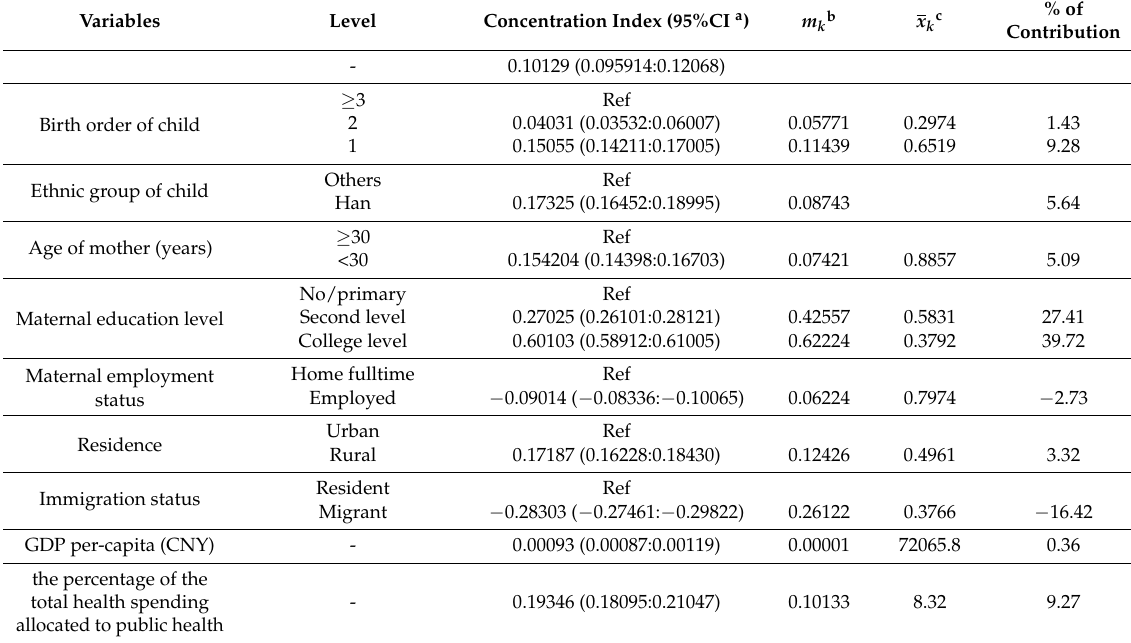
Table 3. The concentration index and contributions of determinants to inequities in the coverage of FPI in the 2017 coverage